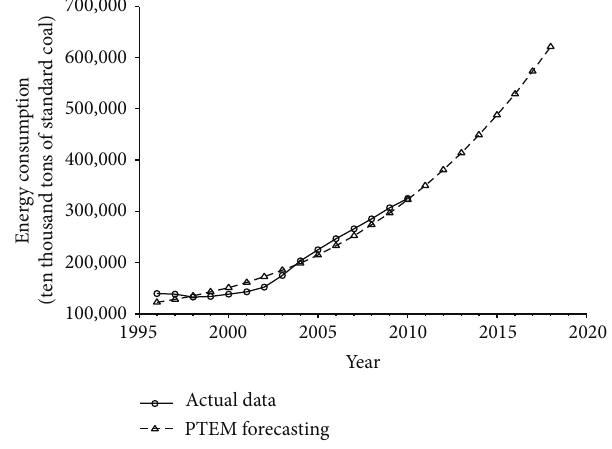
Figure 6: Forecast of China’s energy consumption by